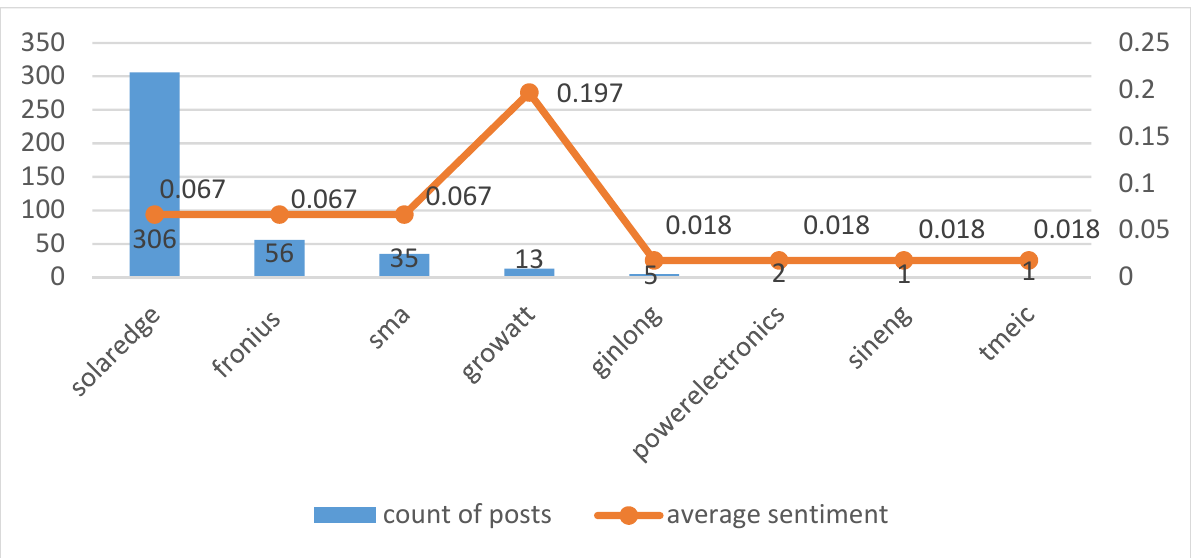
Figure 4. The number of posts and the average sentiments expressed in the posts.